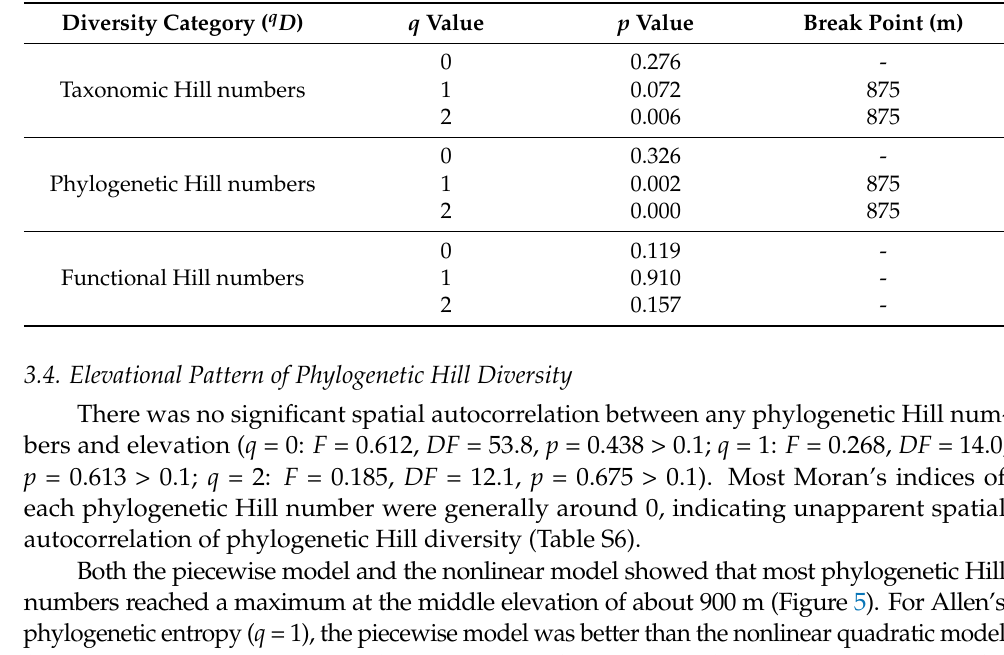
Table 2. Piecewise linear relationships between leaf mine diversity and elevation.